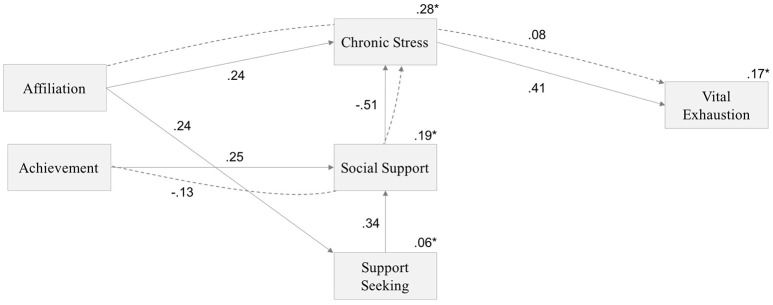
Structural equation model showing direct and indirect relationships between implicit motives, support seeking, perceived social support, perceived chronic stress, and vital exhaustion. Solid arrows indicate direct effects. Dashed arrows show indirect effects of achievement on chronic stress through the mediator social support as well as the indirect effect of affiliation on vital exhaustion through the mediator chronic stress. Significant standardized regression coefficients are shown in the numbers adjacent to the arrows. Numbers with asterick represent variance explained.